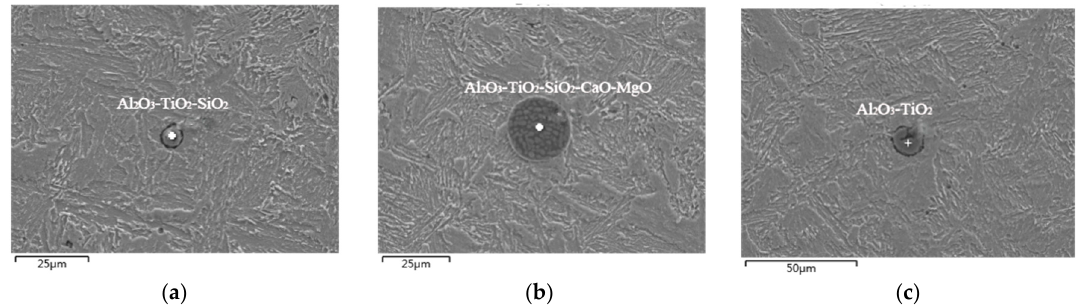
Figure 5. Types and compositions analysis of inclusions at the beginning of refining (Ladle Furnace (LF)). ( a ) Al 2 O 3 -TiO 2 -SiO 2 ; ( b ) Al 2 O 3 -TiO 2 -SiO 2 -CaO-MgO; ( c ) Al 2 O 3 -TiO 2 .